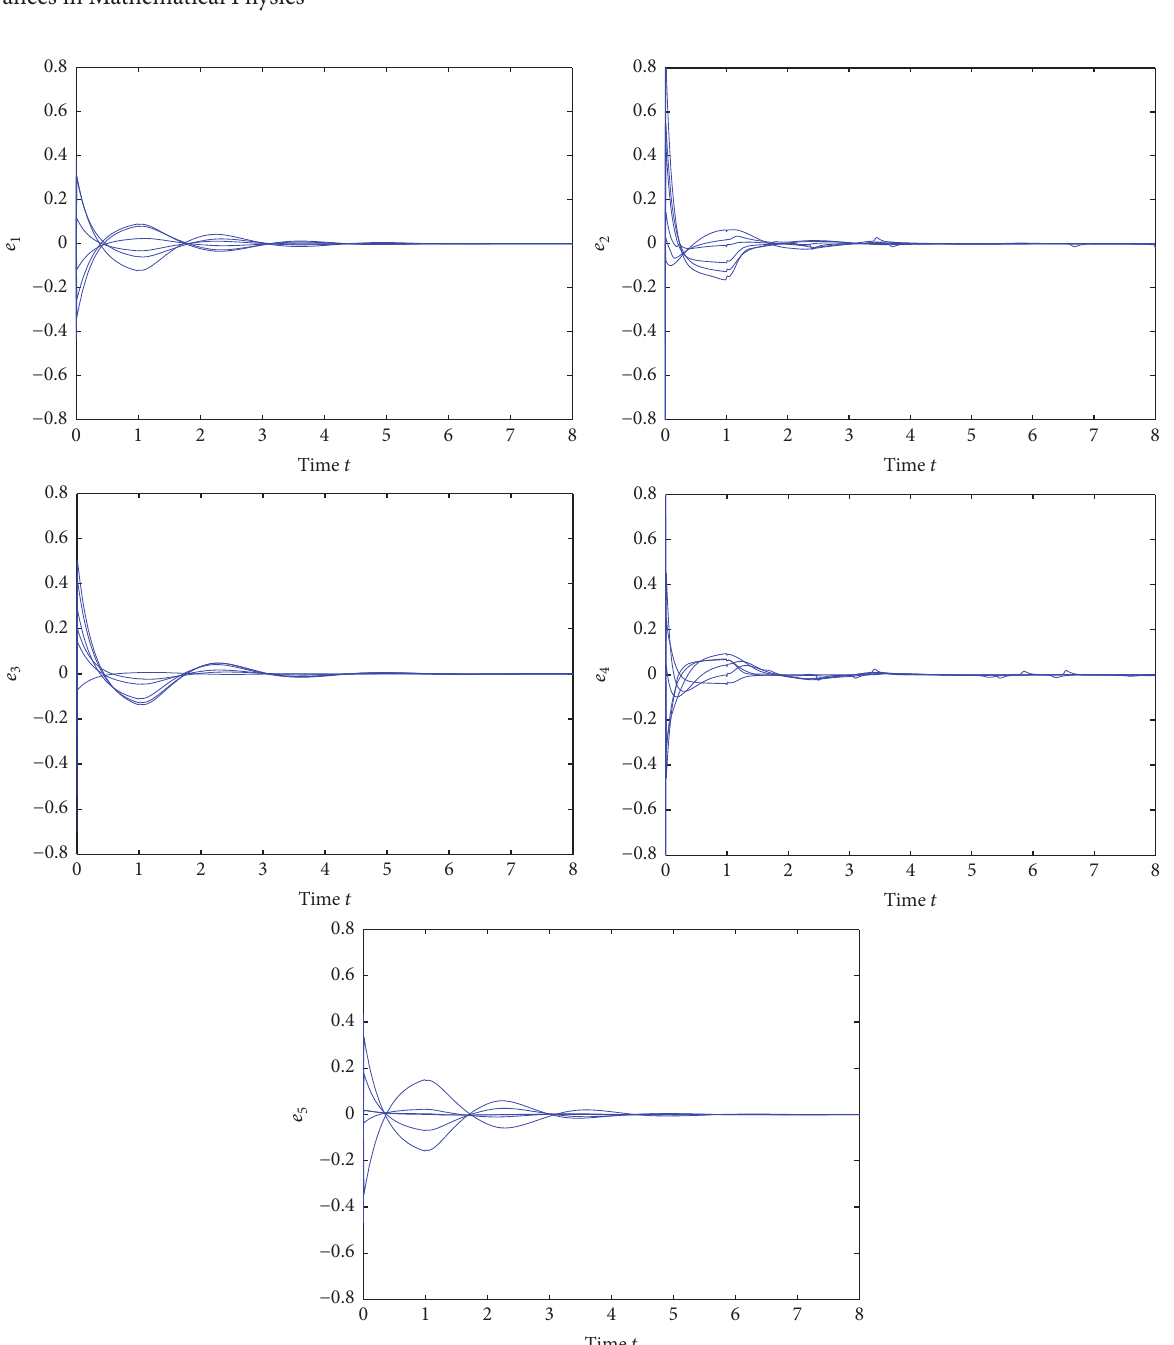
Figure 3: The error dynamics 𝑒 1 (𝑡) = 𝑝 1 (𝑡)− P 1 (𝑡) , 𝑒 2 (𝑡) = 𝑝 2 (𝑡)− P 2 (𝑡) , 𝑒 3 (𝑡) = 𝑝 3 (𝑡)− P 3 (𝑡) , 𝑒 4 (𝑡) = 𝑞 1 (𝑡)− Q 1 (𝑡) , and 𝑒 5 (𝑡) = 𝑞 2 (𝑡)− Q 2 (𝑡)